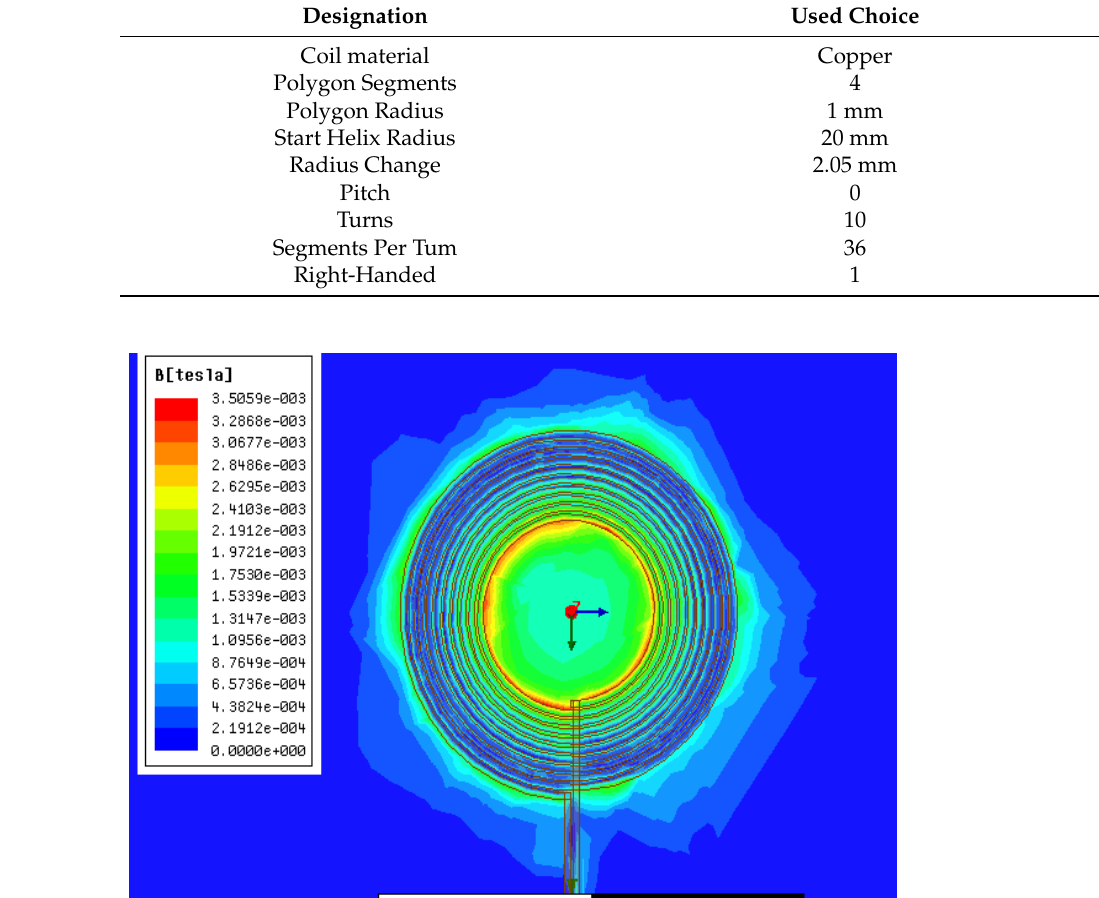
Table 2. Coil used specification on maxwell platform.